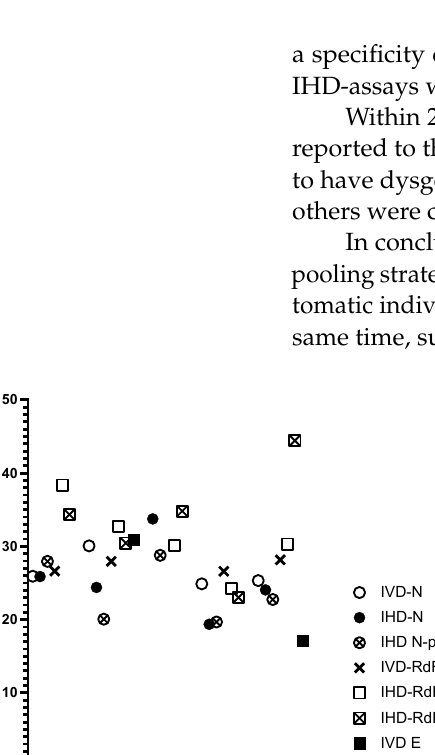
Table 2. Comparison of Ct Values for SARS-CoV-2 targets in samples analyzed with IVD, IHD and IHD-pooled multiplex RT-qPCR assays.